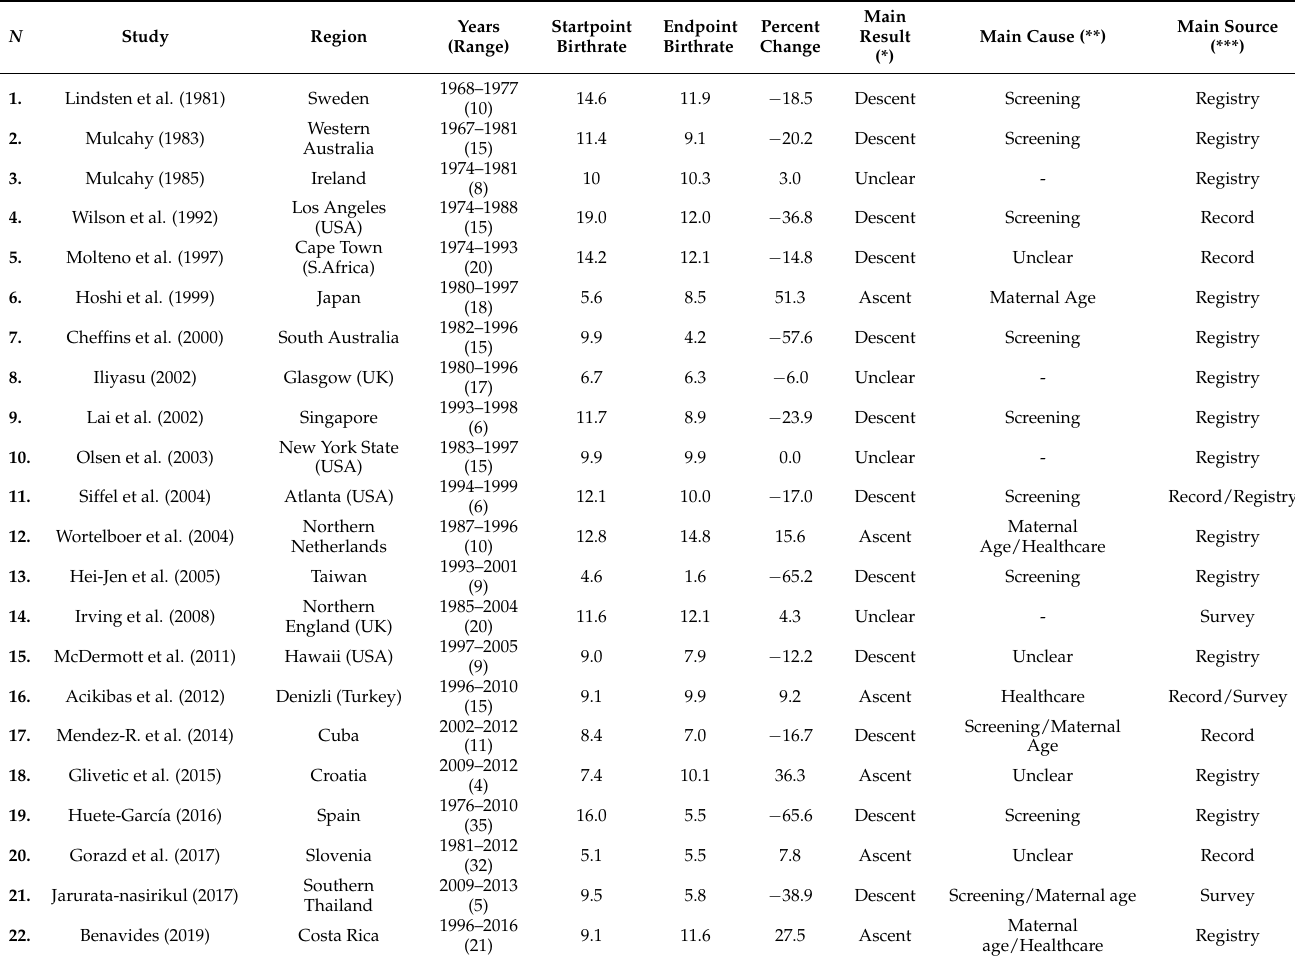
Table 1. Description and main results of studies covered by the systematic review.